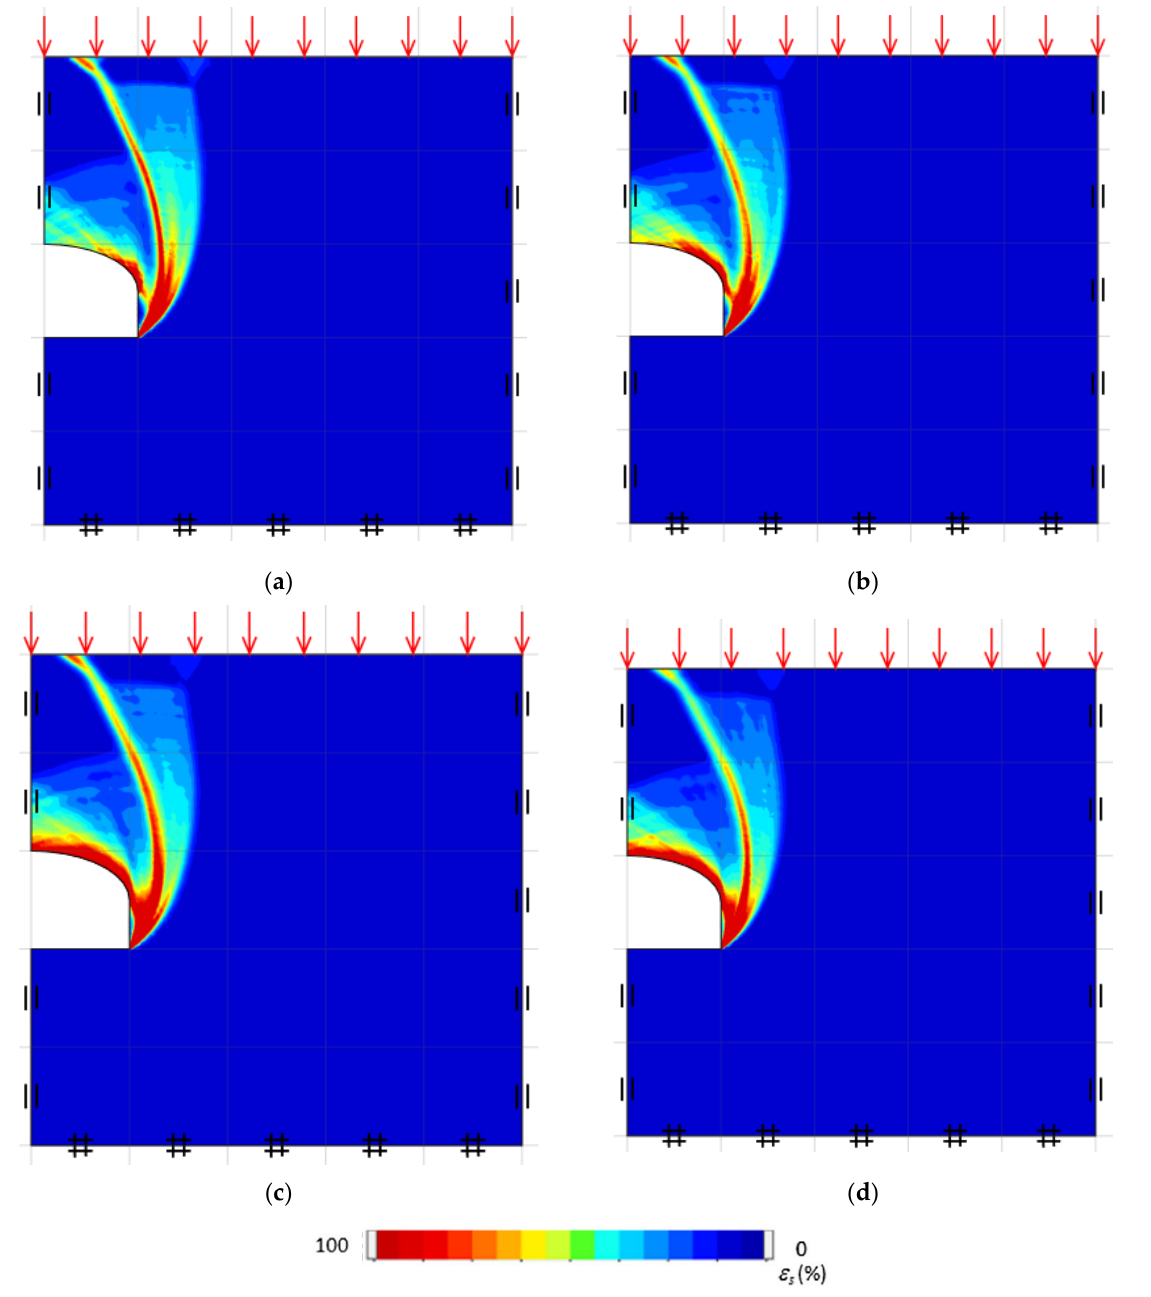
Figure 12. Shear dissipations for various m i : ( a ) 5, ( b ) 10, ( c ) 20 and ( d ) 30 ( C / D = 2, B / D = 2, σ ci / γ D = 1000 and GSI = 80).